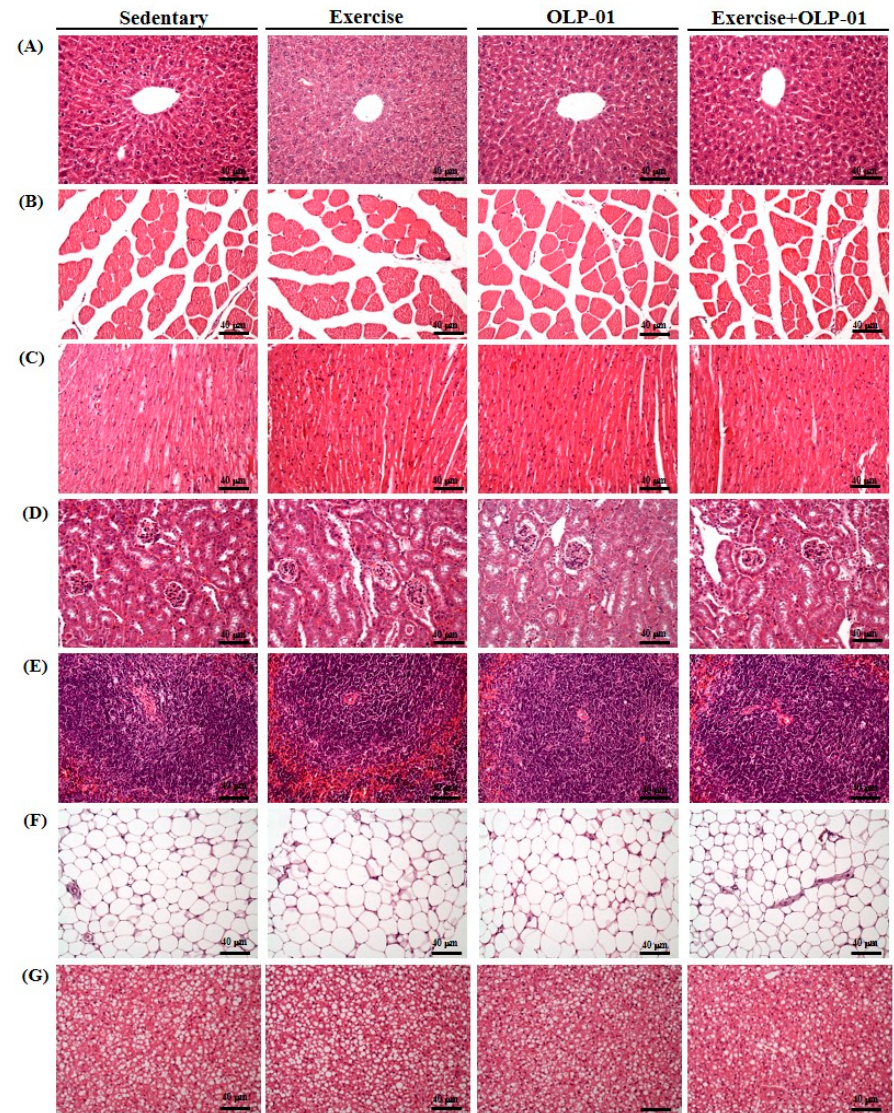
Figure 7. Effects of six weeks of exercise and probiotic interventions on histopathology. ( A ) Liver, ( B ) muscle, ( C ) heart, ( D ) kidney, ( E ) spleen, ( F ) WAT, and ( G ) BAT tissue in mice. Specimens were photographed using a light microscope (H & E staining, magnification: 200×; bar, 20 μ m). WAT, white adipocyte tissue; BAT, brown adipocyte tissue; muscle: gastrocnemius and soleus